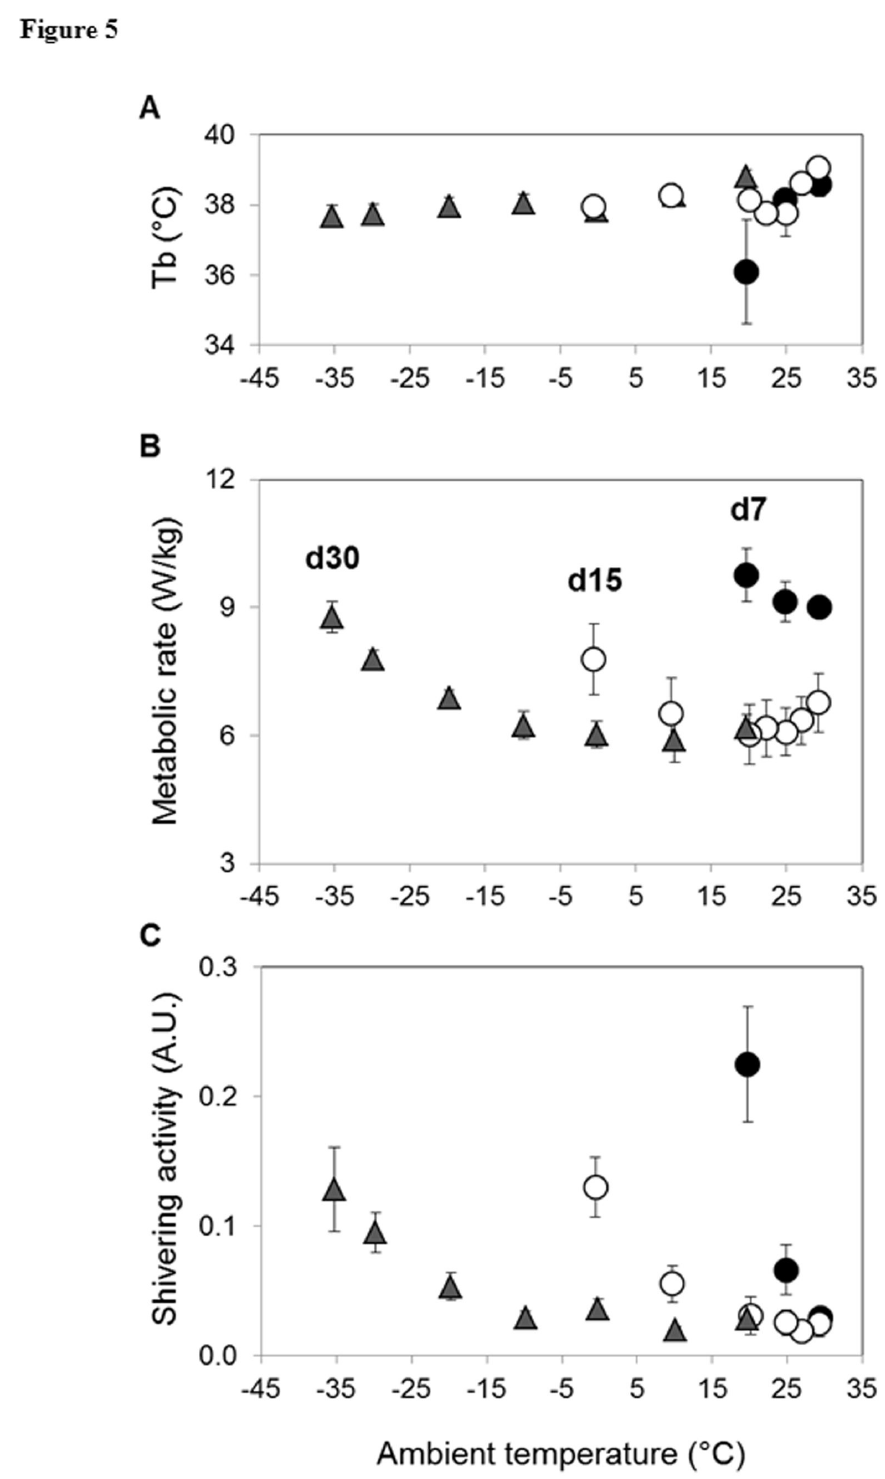
Figure 5. Analysis of whole animal metabolism response to cold. Relationship between body temperature (panel A), whole- animal metabolic rate (panel B), shivering activity (panel C) and ambient temperature in 7, 15 and 30-day- old Adélie penguins. Values are means ± S.E.M. from 9–12 individuals per age. When not visible, error bars are within the symbols. Symbols are as follows: D7, black circles; D15, white circles; D30, grey triangles. doi: 10.1371/journal.pone.0074154.g005 PLOS ONE |